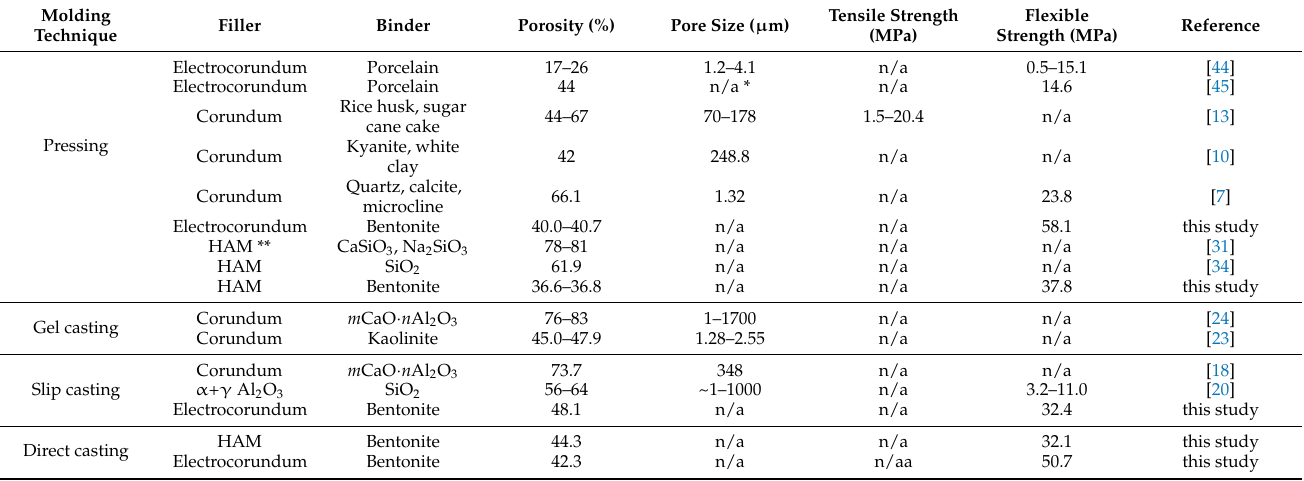
Table 1. Properties of porous alumina ceramics produced by pressing and casting techniques with different